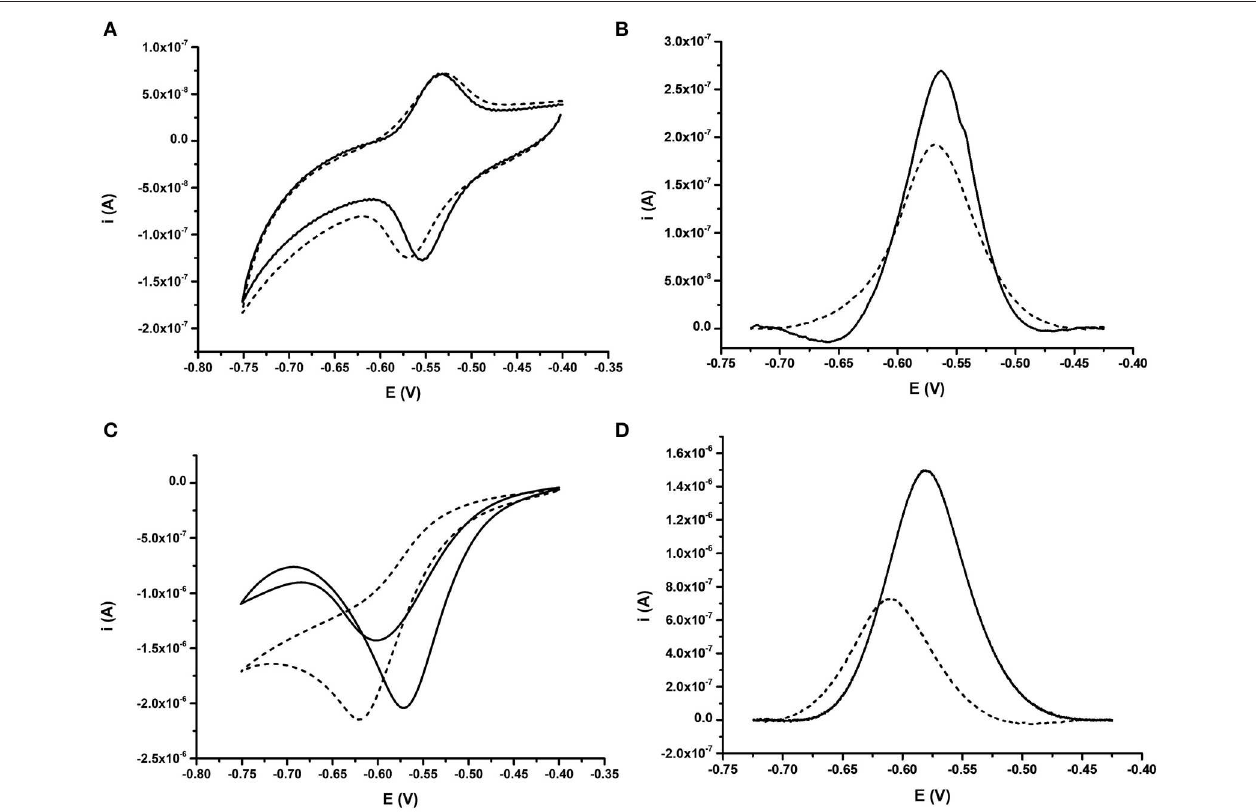
FIGURE 3 | Comparative behavior of probe BA-1 in response to fully complementary DNA under oxygenated and deoxygenated conditions. (A) CV and (B) DPV for probe under deoxygenated conditions; achieved by purging the electrolyte (10mM Tris pH 8.0 containing 0.5M NaCl) with argon for 30min prior to analysis. (C) CV and (D) DPV for probe in buffer containing oxygen. In each case the signal from the ssDNA probe modified with AQ is shown as a solid line while the response after hybridization of fully complementary DNA is shown with a dashed line. The response of the same electrode under all conditions is shown. Electrochemical scans were performed at 50mV s − 1 vs. SCE.